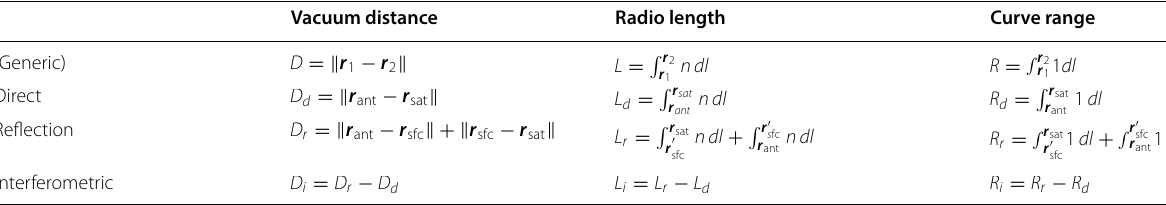
Table 1 Definition of the propagation quantities Vacuum distance Radio length Curve